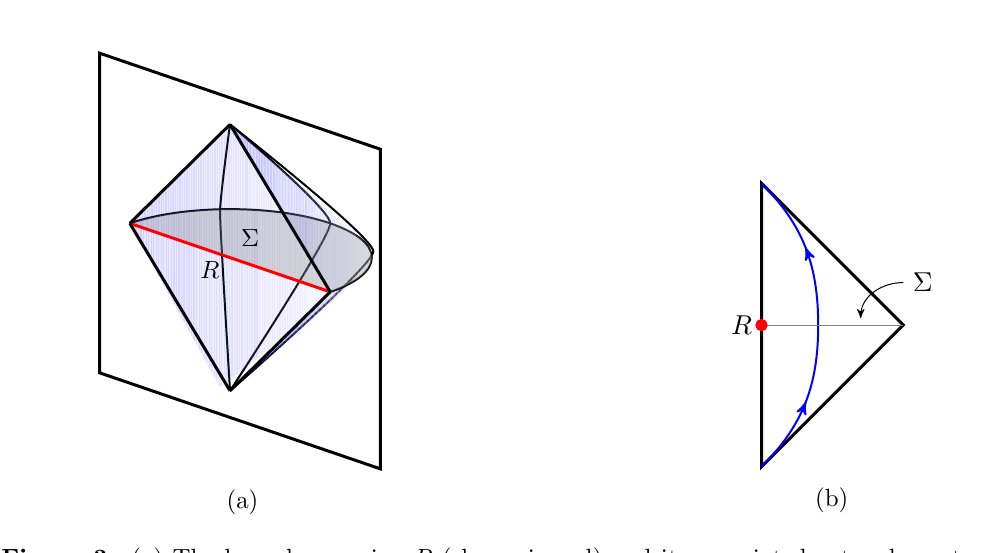
Figure 3. (a) The boundary region R (shown in red) and its associated entanglement wedge W (shown as the blue shaded region). Σ (shown in grey) is a spacelike slice of the wedge that is anchored to R and the extremal surface. (b) A lower dimensional slice of the entanglement wedge. When the reference state is the vacuum, modular flow moves operators along the blue